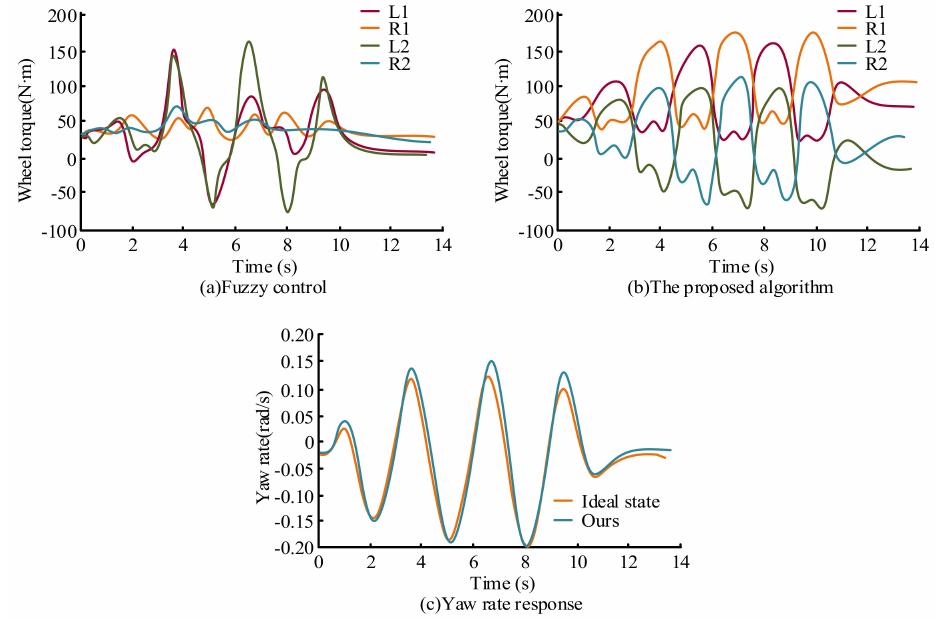
Figure 10. Regulation effect of wheel torque and yaw rate under serpentine